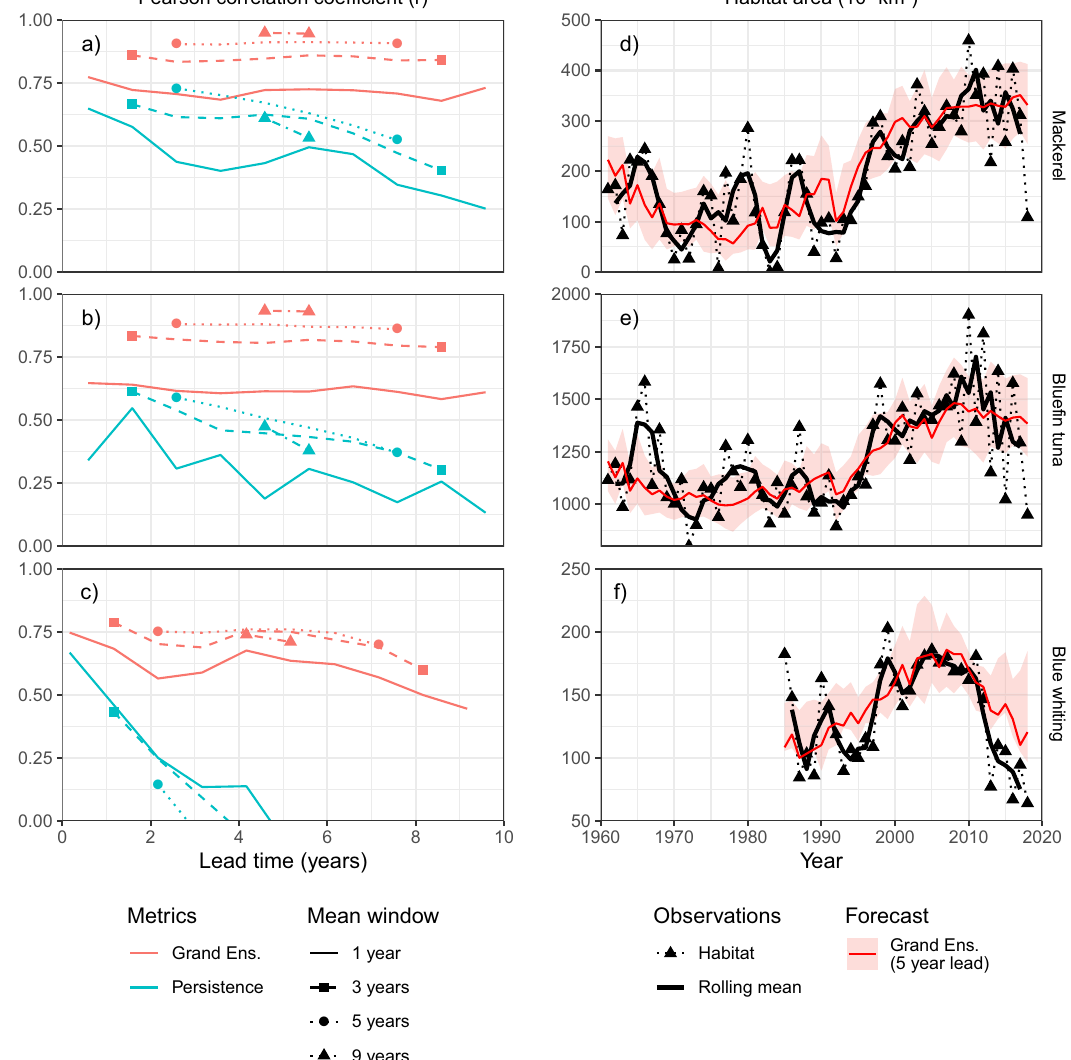
Fig. 3 Habitat forecasts capture low-frequency variability. The forecast skill of multi-annual averages of habitat area (panels a - c ), as characterised by the Pearson correlation coef fi cient ( r ), is shown for the grand-ensemble and persistence forecasts. In addition to the single-year values also plotted in Fig. 2 (solid lines), the skill of multi-year averages (3, 5, and 9 year centred means) are also shown (broken lines with symbols). Lead-time is de fi ned as the length of time from the issuing of the forecast (1 January) to the middle of the running mean window. Multiyear forecasts are signi fi cantly better than multiyear persistence for all lead times ( p < 0.01, one-tailed test, as estimated by bootstrapping). Time-series of habitat metrics (panels d - f ) show habitat estimates based on observations (triangles connected by dotted line) with their three-year running means (solid black lines). Habitat metrics forecast by the grand-ensemble (solid red line) with a 5-year lead time are shown with the corresponding 90% range of realizations (shaded area). Time series are shown for the full range of years used to estimate the forecast performance (i.e., 1961 – 2018 for mackerel and blue fi n tuna, 1985 – 2018 for blue whiting). Panels ( a ) and ( d ) show results for the area of mackerel habitat around south Greenland, panels ( b ) and ( e ) blue fi n tuna habitat south of Iceland, and ( c ) and ( f ) blue whiting spawning habitat west of Great Britain and Ireland. Source data are provided as a Source Data fi